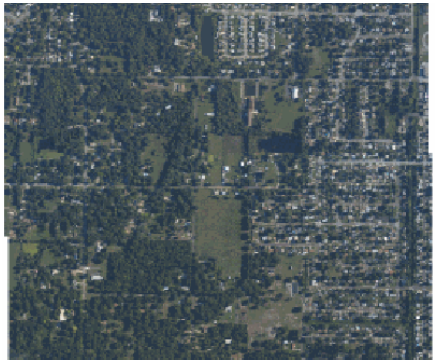
Figure 6. Images after color